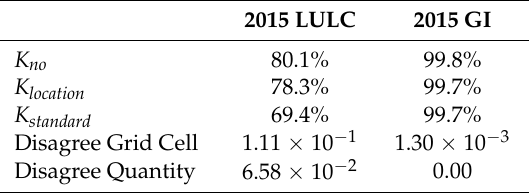
Table 6. The Kappa scores and disagreement scores used to validate the predicted 2015 landcover against the reference 2015 landcover, and the 2015 GI against the reference 2015